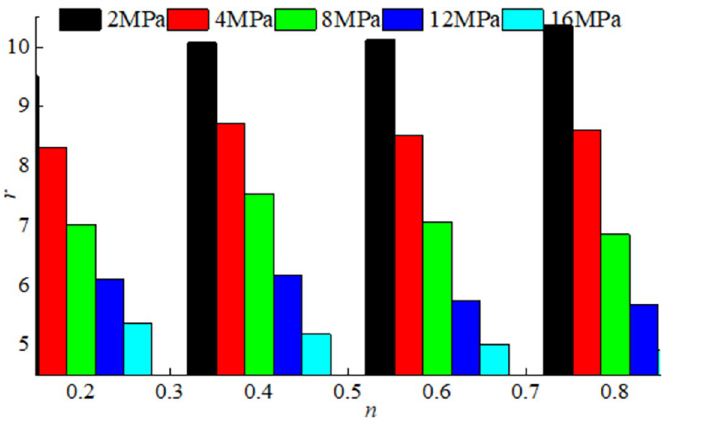
Fig 9. Histogram of r - n